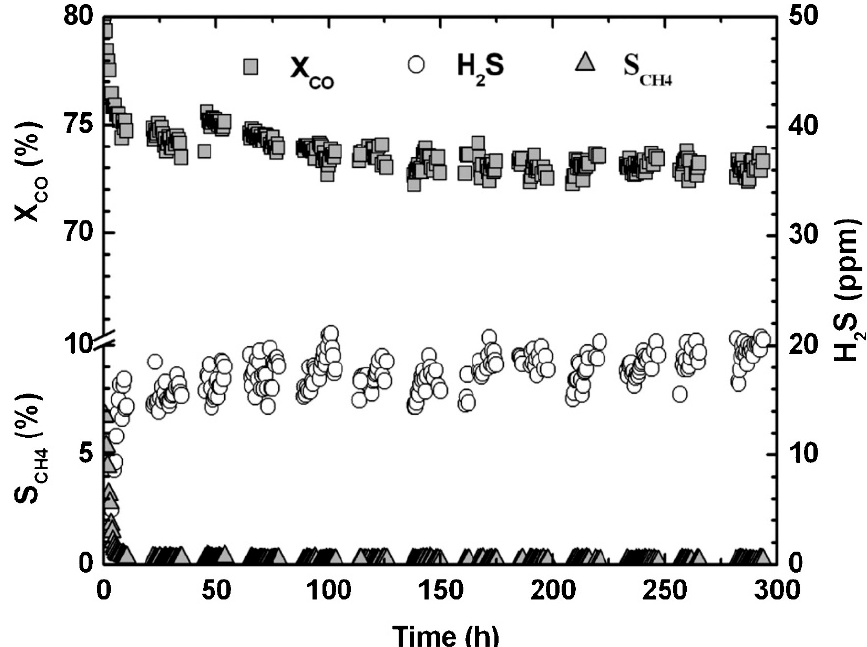
Figure 25. 300 h stability test over 1% Pt/CeO 2 catalyst in the presence of 20 ppm H 2 S at 400 °C and S/CO = 2, reproduced or adapted from [193], with permission from Elsevier, 2011.